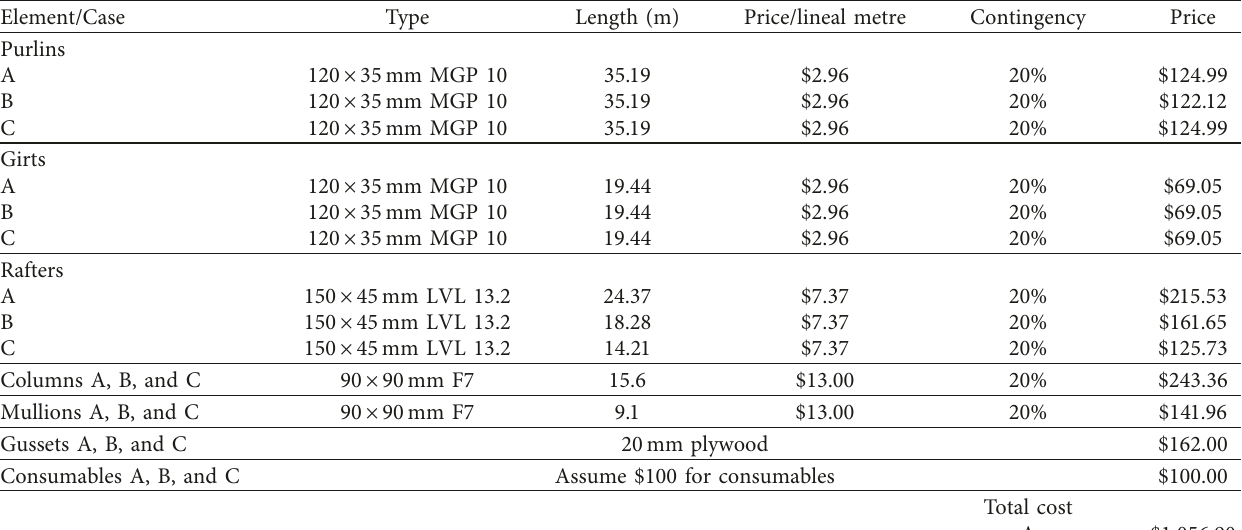
Table 2: Summary of portal element costs.